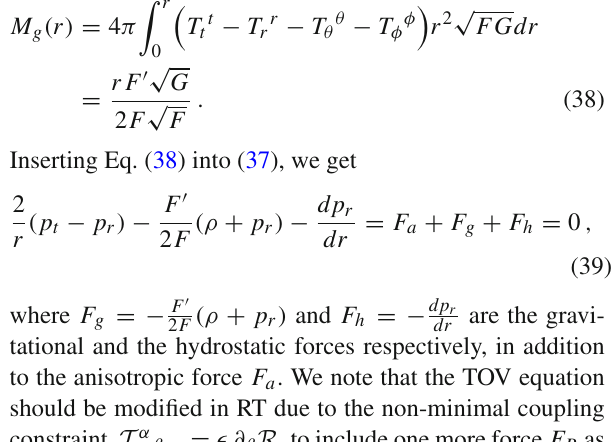
pactness values. The redshift is finite everywhere within the pulsar and decreases toward the surface as stated by condition (x) in Sect. 4 and also predict a surface redshift consistent with the upper limit constraints as given by